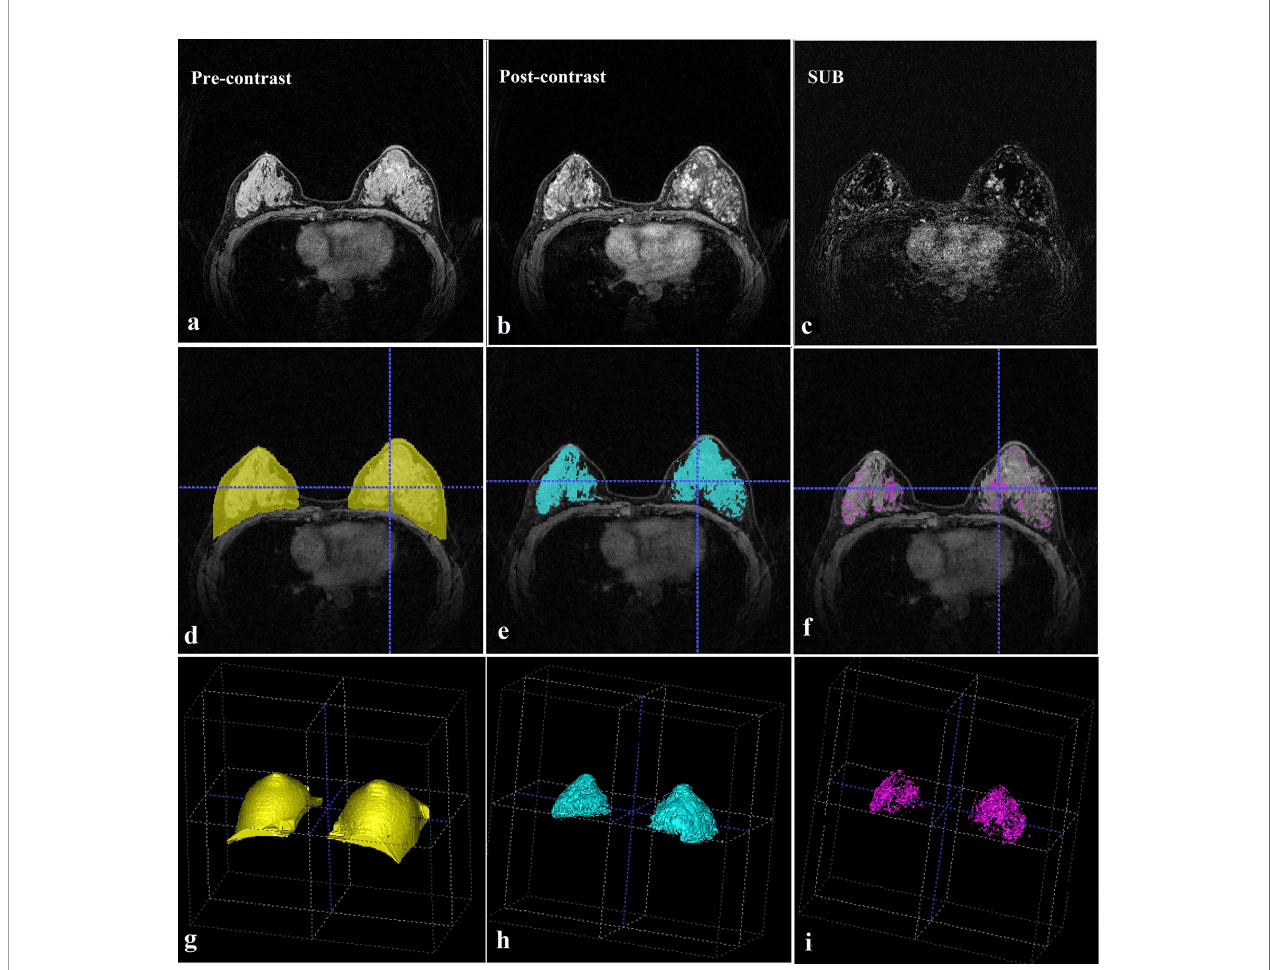
FIGURE 1 | MRI evaluation. (A) Pre-contrast breast MRI (T1-weighted fat-suppressed sequence). (B) This post-contrast (early) image corresponds to the T1-weighted image shown in (A) . (C) Subtraction image from (A, B) . (D) Whole breast segmentation (yellow). (E) Fibroglandular tissue segmentation (blue). (F) Enhanced fi broglandular tissue segmentation (purple). (G) Whole breast segmentation (3D). (H) Fibroglandular tissue segmentation (3D). (I) Enhanced fi broglandular tissue segmentation (3D). MRI = magnetic resonance imaging, 3D =